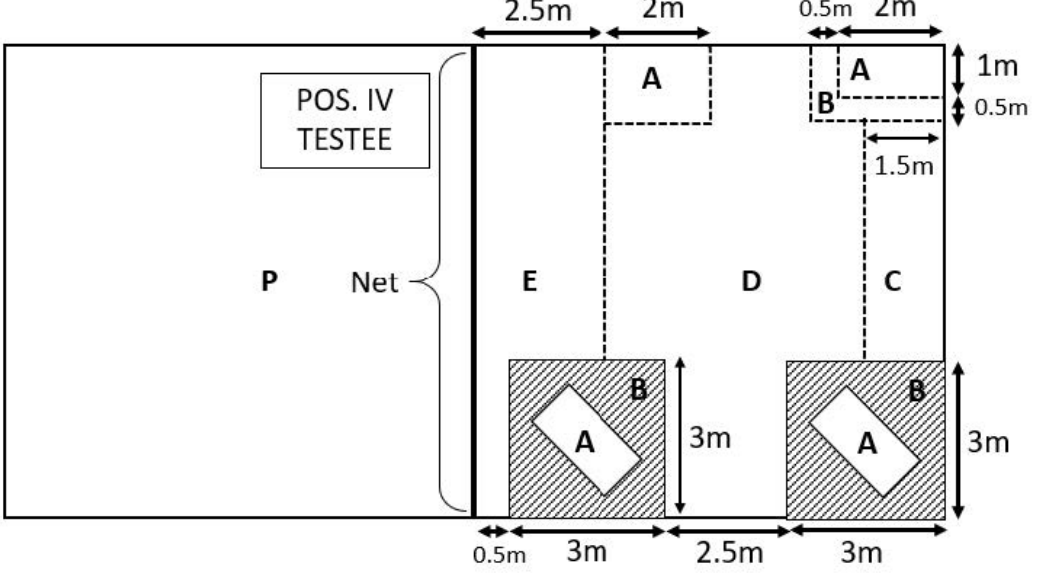
Figure 1. Upper view of scoring area of spikes